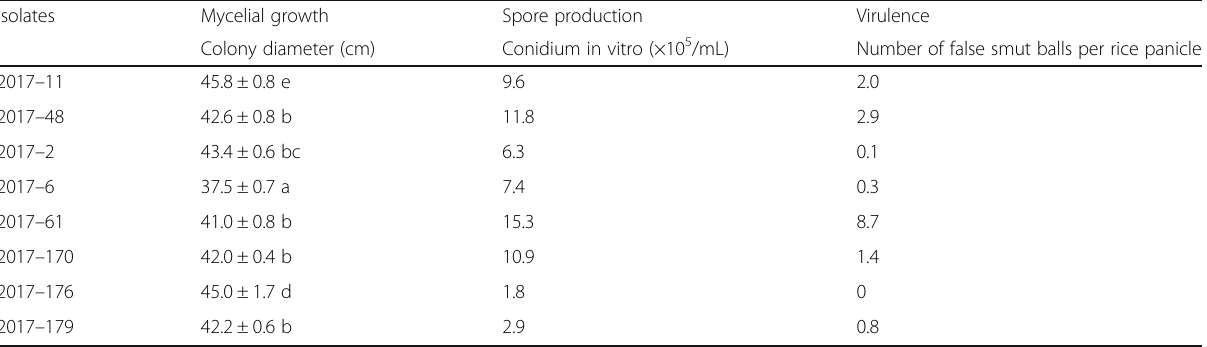
Table 4 Mycelial growth, sporulation and virulence of propiconazole-resistant isolates